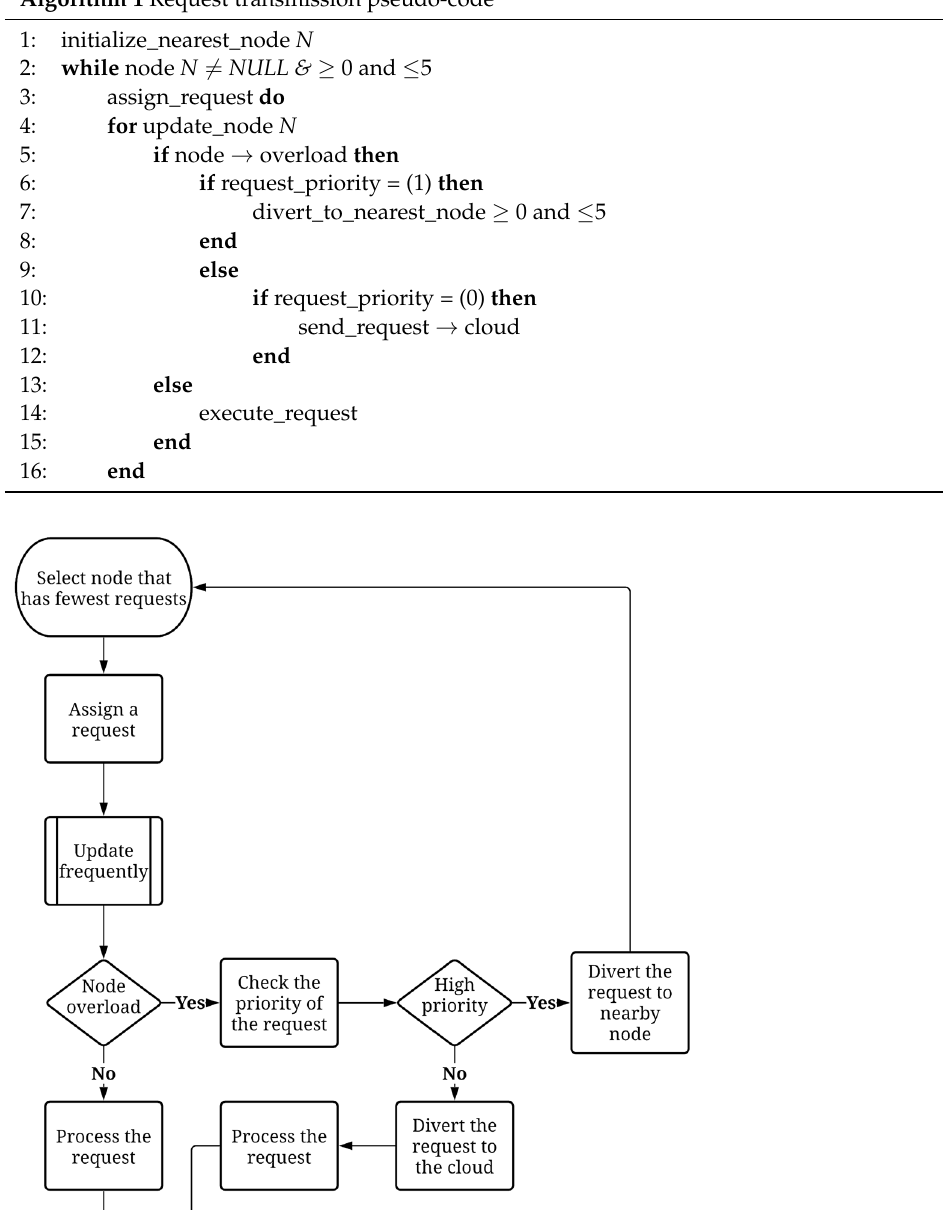
Table 1. Fog scenario 1.